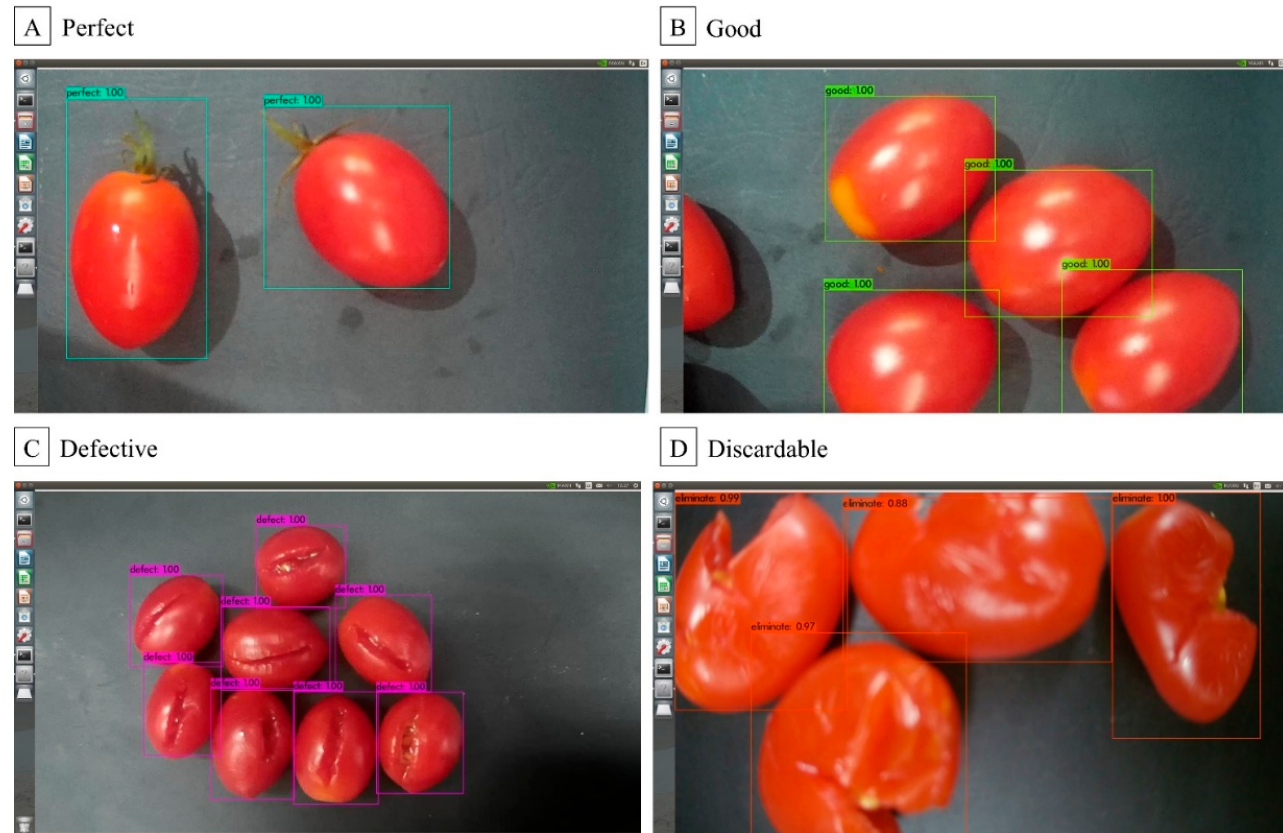
Figure 6. Result of YOLOv4-driven appearance grading filing mechanism.